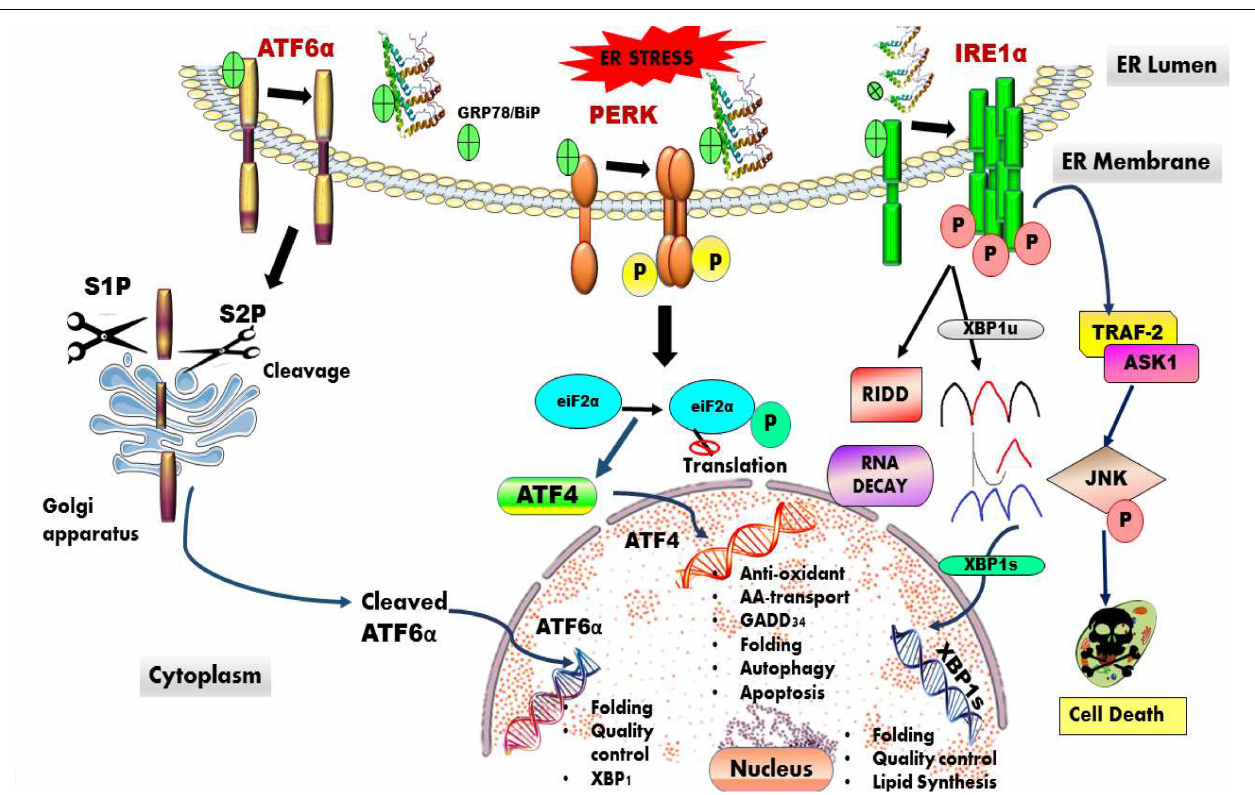
FIGURE 1 | Overview of ER-induced UPR stress signaling pathway. The UPR is an adaptive mechanism activated in response to ER stress. The three UPR stress sensing proteins that are activated are IRE1, PERK, and ATF6, which work independently with an aim to maintain protestatic balance via decreasing the load of misfolded proteins and restoring ER protein